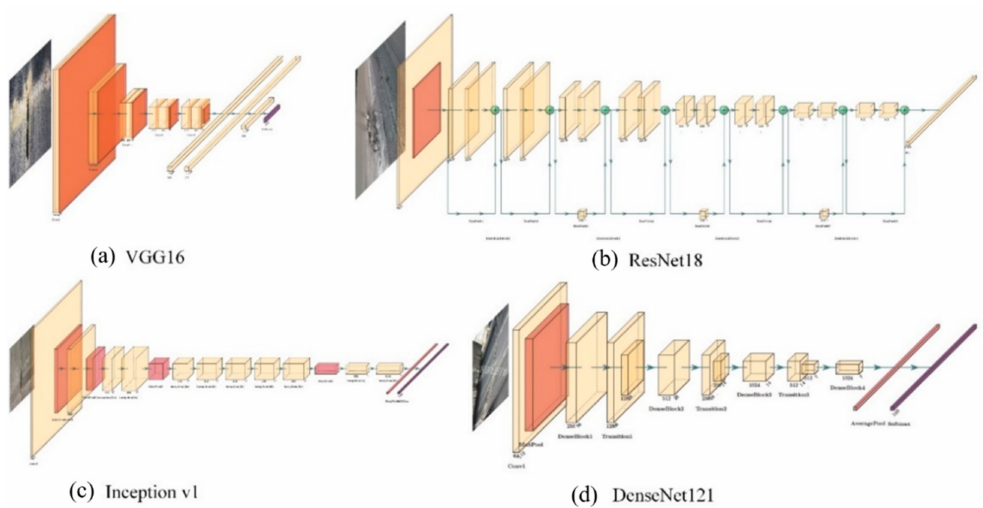
Figure 8. Architecture of deep neural networks: ( a ) VGG16; ( b ) ResNet18; ( c ) Inception; ( d )